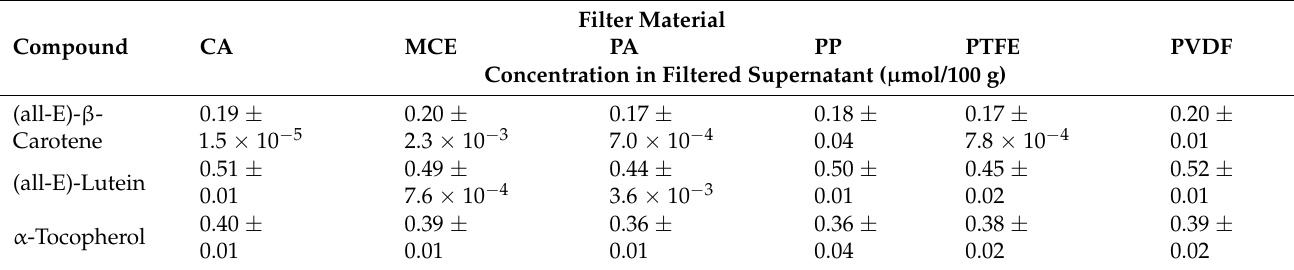
Table 3. Concentrations of (all-E)- β -carotene, (all-E)-lutein, and (all-rac)- α -tocopherol after filtration of an aqueous su- pernatant derived from in vitro digestion of kale using different syringe membrane materials (0.45 µ m pore size, 25 mm diameter). Tested membrane materials consisted of cellulose acetate (CA), mixed cellulose ester (MCE), polyamide (PA), polypropylene (PP), polytetrafluoroethylene (PTFE), and polyvinylidene difluoride (PVDF). Filter